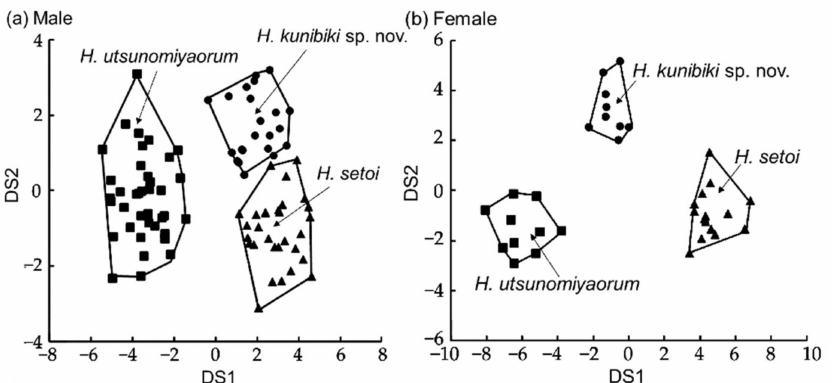
Figure 3. Two-dimensional plots based on canonical discriminant analysis. The x and y axes indicate discriminant score 1 (DS1) and discriminant score 2 (DS2), respectively. The contribution ratios of DS1 and DS2 in males and females were as follows: DS1: 88.90% for males, 83.96% for females; DS2: 11.10% for males, 16.04% for females. Circles, triangles, and squares indicate scores for individuals from the type localities of Hynobius kunibiki sp. nov., H. setoi , and H. utsunomiyaorum , respectively.